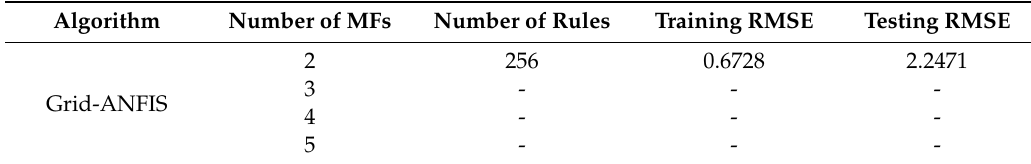
Table 1. Prediction experiment results from grid-based ANFIS.